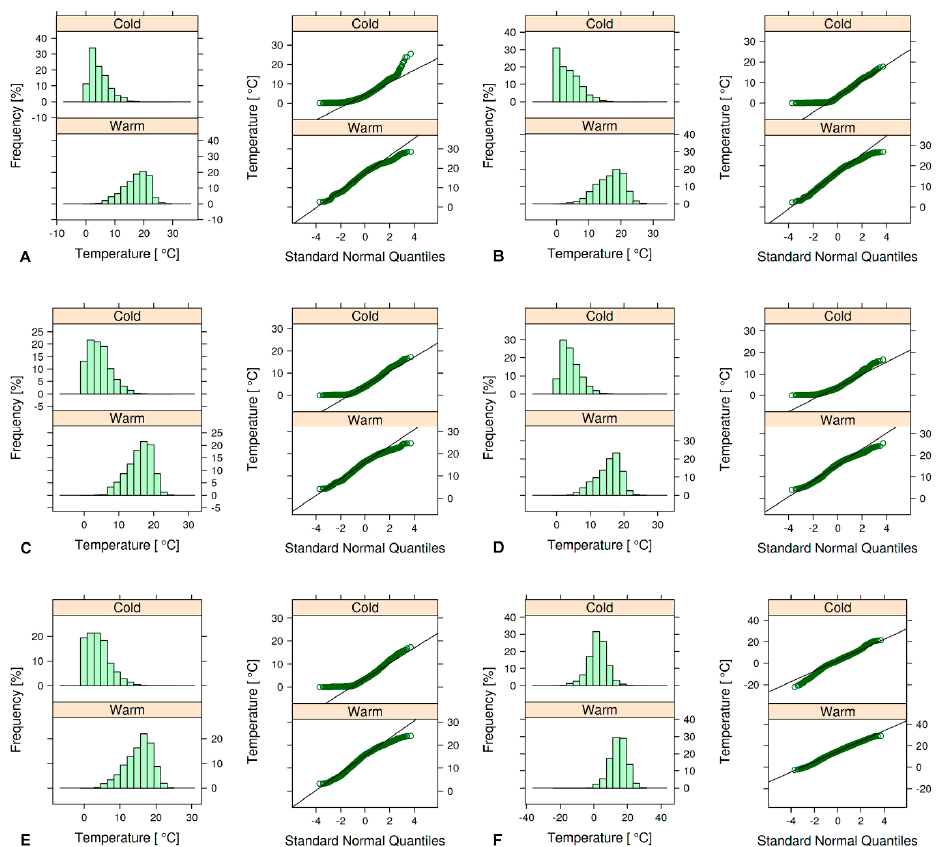
Figure 3. Frequency histograms and quantile plots of the distribution of semi-annual water temperature series for the Note ć and its tributaries, and of air temperature (1987–2013): ( A ) Note ć – Pako ść , ( B ) Note ć –Uj ś cie, ( C ) Note ć –Nowe Drezdenko, ( D ) Drawa–Drawiny, ( E ) Gwda–Pi ł a, ( F ) Pi ł a (weather station). Table 1. Descriptive statistics of the distribution of river water temperature “tw” ( ° C) and air temperature “ta” (°C) in the Note ć catchment on the multi-year and half-year levels (1987–2013).